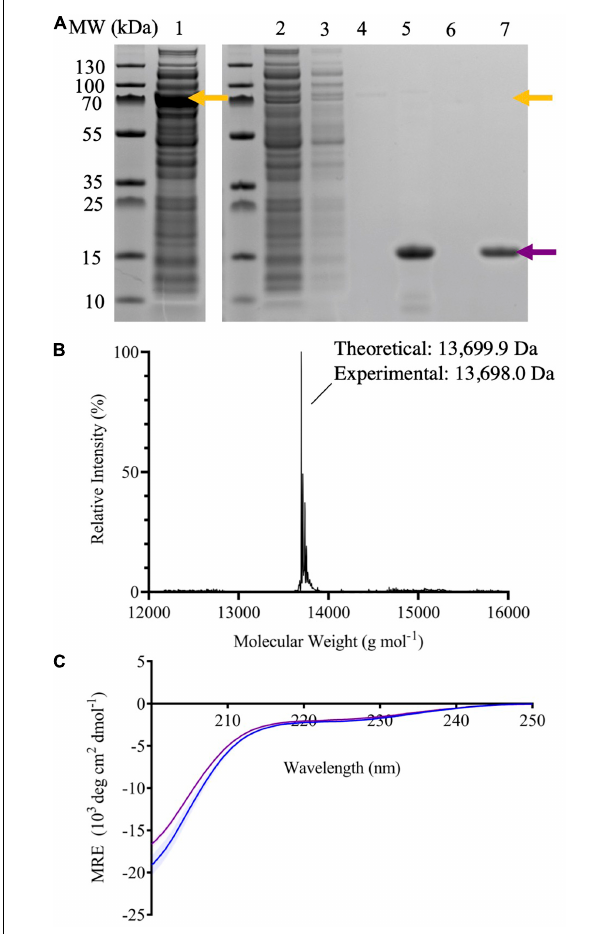
FIGURE 2 | (A) SDS-PAGE of samples taken throughout the purification process of 7–140 α -syn; crude extract (lane 1), flow through after passing the crude extract through the column five times (lane 2), flow through after washing the column with column buffer (lane 3), flow through after equilibrating the column with cleavage buffer (lane 4), compiled fractions containing the target protein after dialysis (lane 5), flow through after stripping the column with NaOH (lane 6), and the target protein purified by SEC (lane 7). The yellow arrows indicate the molecular weight (MW) of the fusion protein, while the purple arrow the one of 7–140 α -syn. (B) The deconvoluted ESI-MS spectrum of 7–140 α -syn. Theoretical mass 13,699.9 Da, experimental mass 13,698.0 Da. (C) The CD spectra of monomeric WT α -syn (blue) and 7–140 α -syn (purple). n = 3, error bars representing the standard deviation are shown as transparent bars.